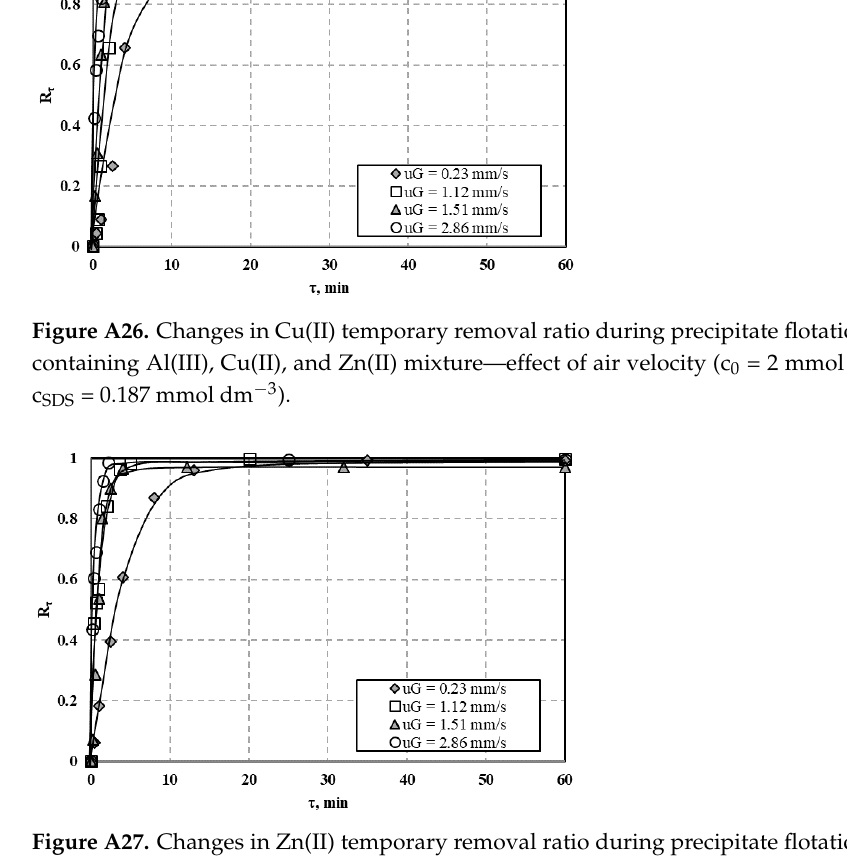
Figure A27. Changes in Zn(II) temporary removal ratio during precipitate flotation from solution containing Al(III), Cu(II), and Zn(II) mixture—effect of air velocity (c 0 = 2 mmol dm − 3 , pH = 8.7, c SDS = 0.187 mmol dm − 3 ).